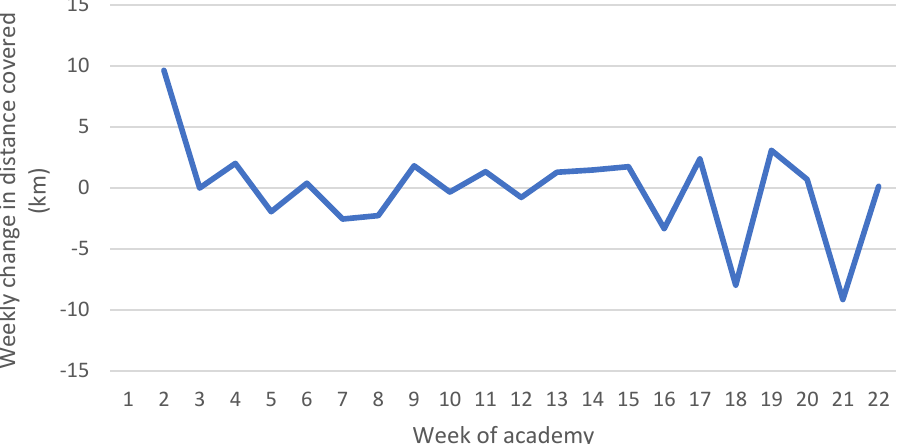
Figure 3. Average weekly change in distance covered across seven academy classes.